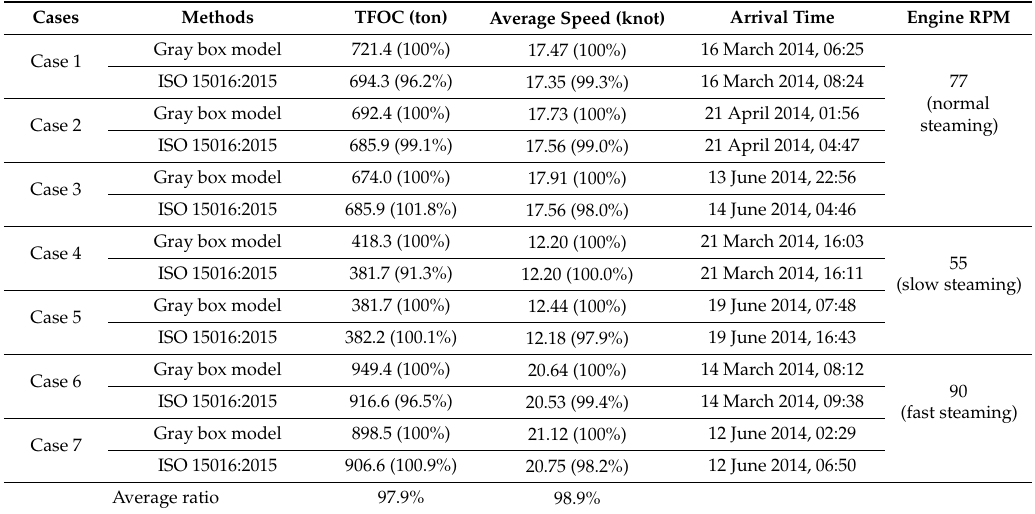
Table 4. Summary of results of total fuel oil consumption (TFOC) and average